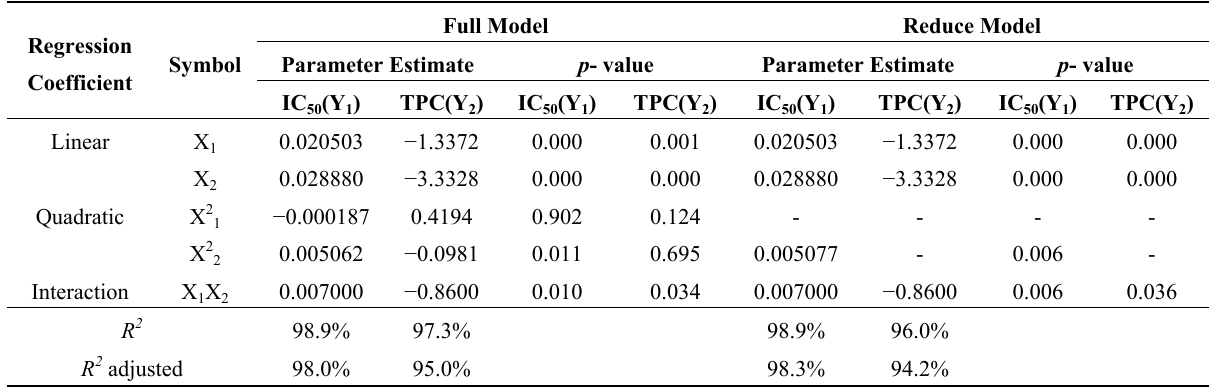
Table 2. Regression coefficient parameters of samples extracted with 80% methanol.